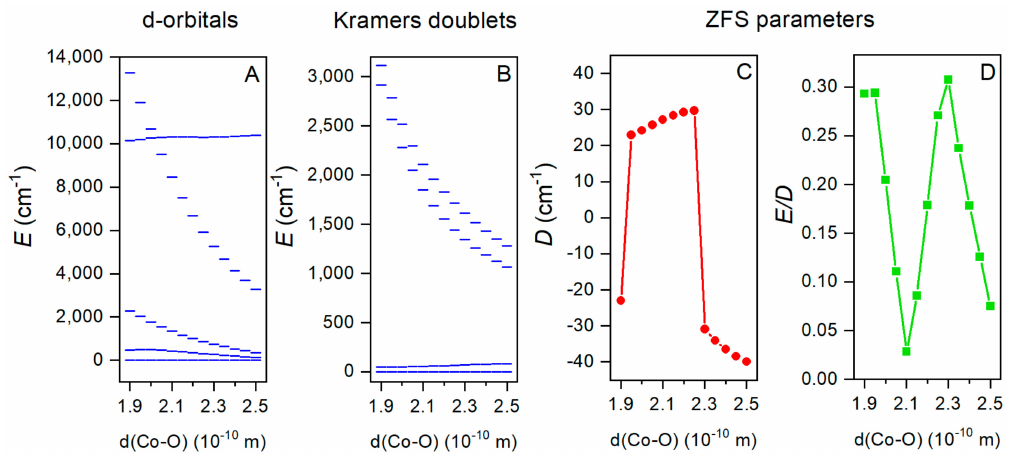
Figure 9. The graphical output of the CASSCF / NEVPT2 calculations with CAS(7,5) for the mononuclear molecular fragments of [Co(fpo) 2 (H 2 O) 2 ] 2 + of 2 for varying d(Co-O) bond distances. The plot of the d-orbitals splitting calculated by ab initio ligand field theory (AILFT) ( A ), four low-lying Kramers doublets ( B ), and the zero-field splitting parameters D and E ( C and D